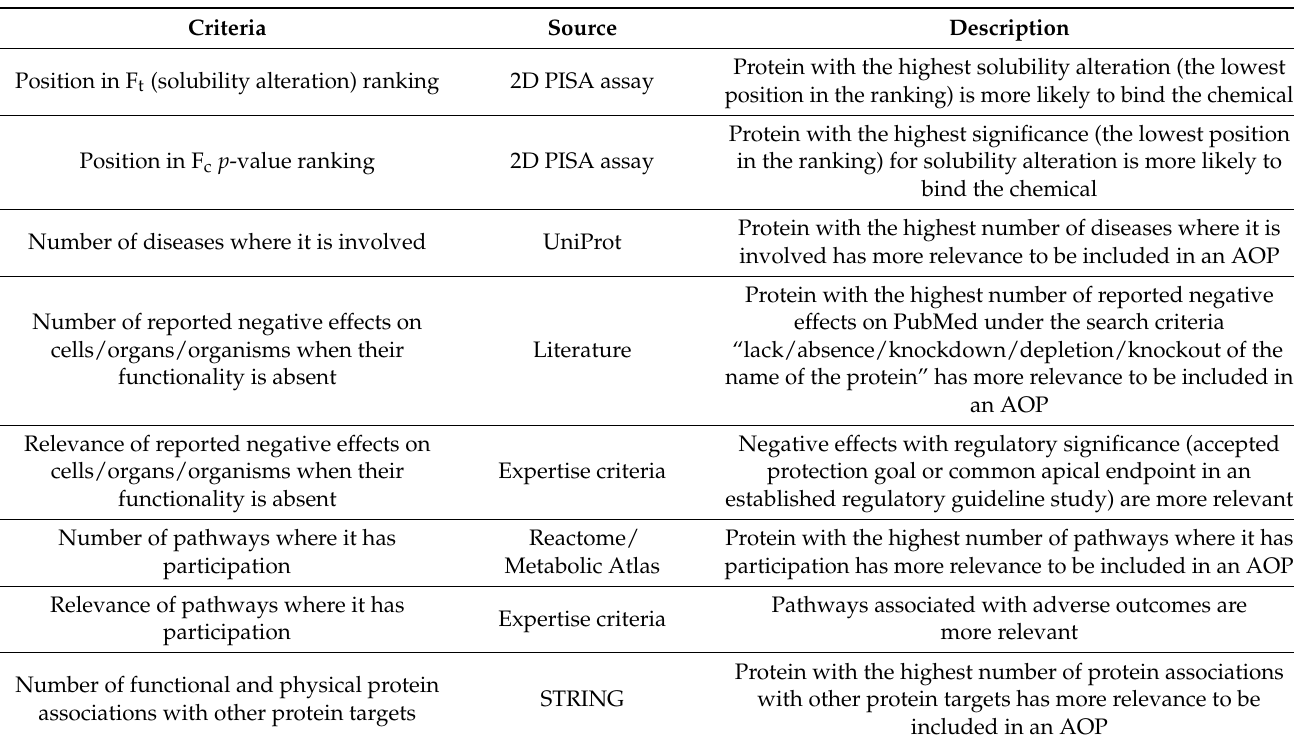
Table 2. Description of the selected criteria that contribute to the overall goal of selecting by AHP from identified protein targets by 2D PISA assay the priority one for